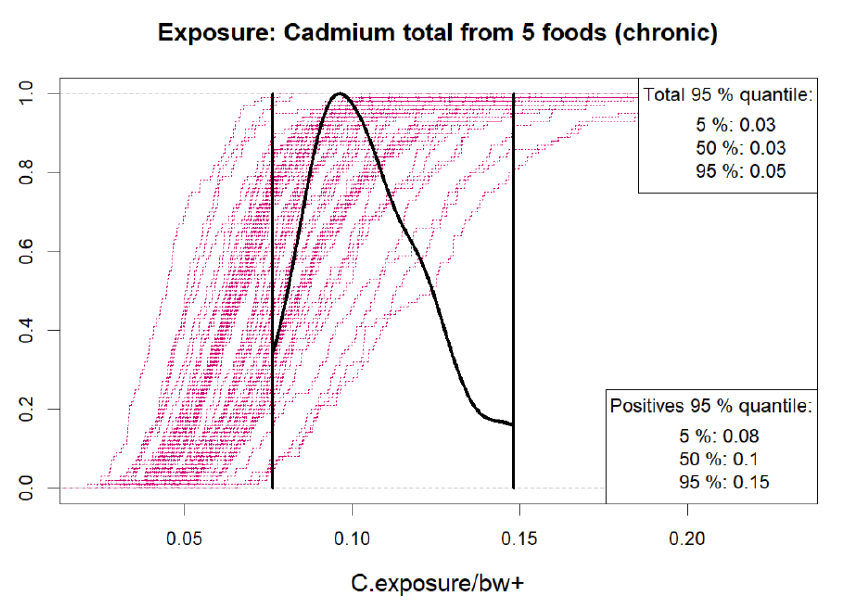
Figure 5. Uncertainty sample of cumulative distributions (magenta) of total positive exposures per body weight, from five selected food types, assuming positive concentrations & positive consumption days for all those foods. Uncertainty distribution of the chosen exposure quantile (here 95%) is shown as a density plot (black) within 90% uncertainty bounds (vertical bars). Numerical estimates for the chosen quantile are shown both for strictly positive exposure days only (lower corner) and for all days, which include zero consumption days and zero occurrences (upper corner). The “total quantile” hence represents the real exposure quantile whereas the “positives quantile” (and the plot) ignores zero exposure days. Numerical values on horizontal axis depend on what measurement units were used in the user’s data.